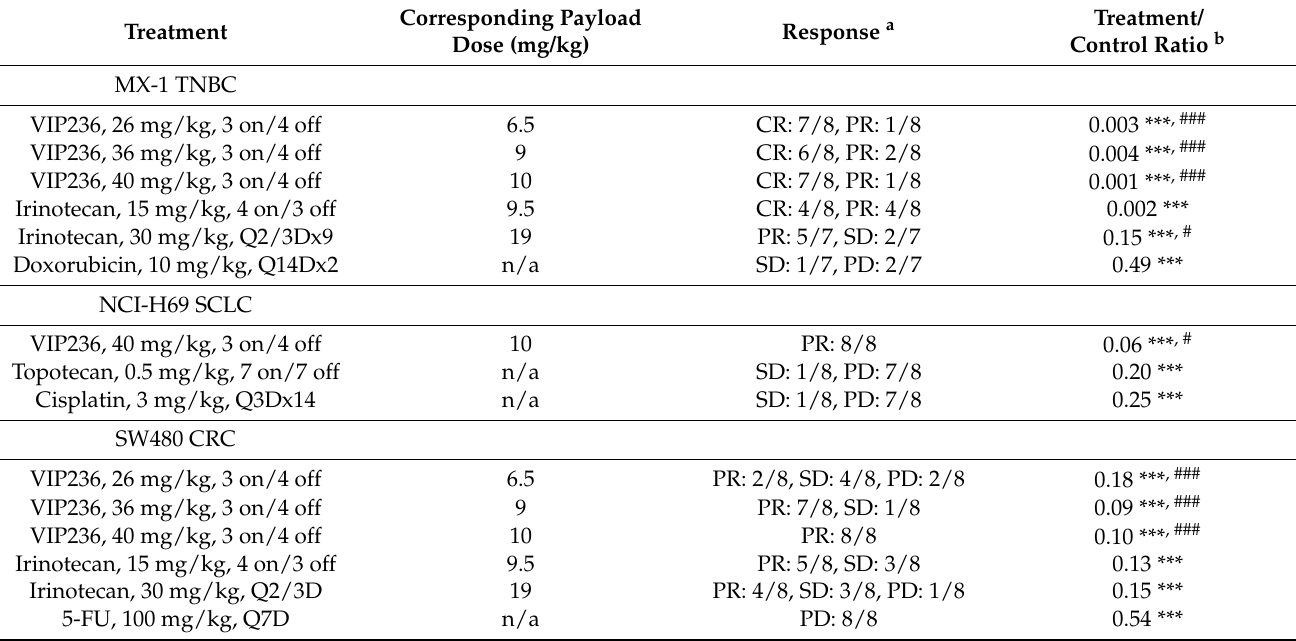
Table 6. Antitumor efficacy of VIP236 and the reference compounds in the MX-1 breast cancer, NCI-H69 lung cancer, and SW480 colorectal cancer